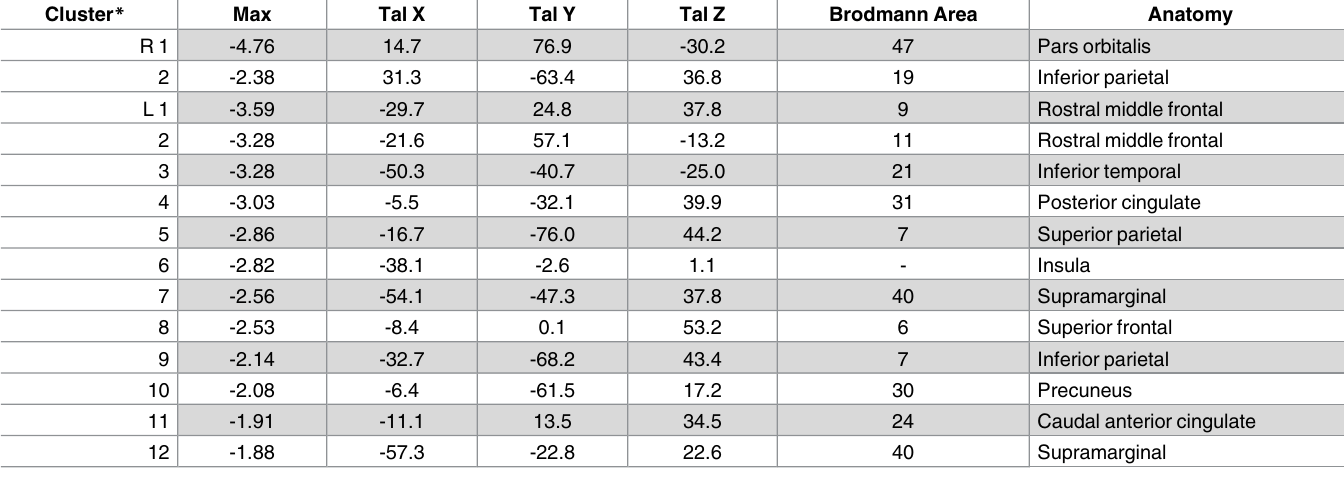
Table 4. Clusters of significant negative correlation with pain duration reported at the peak coordinates, (Rt. & Lt. hemispheres). Cluster